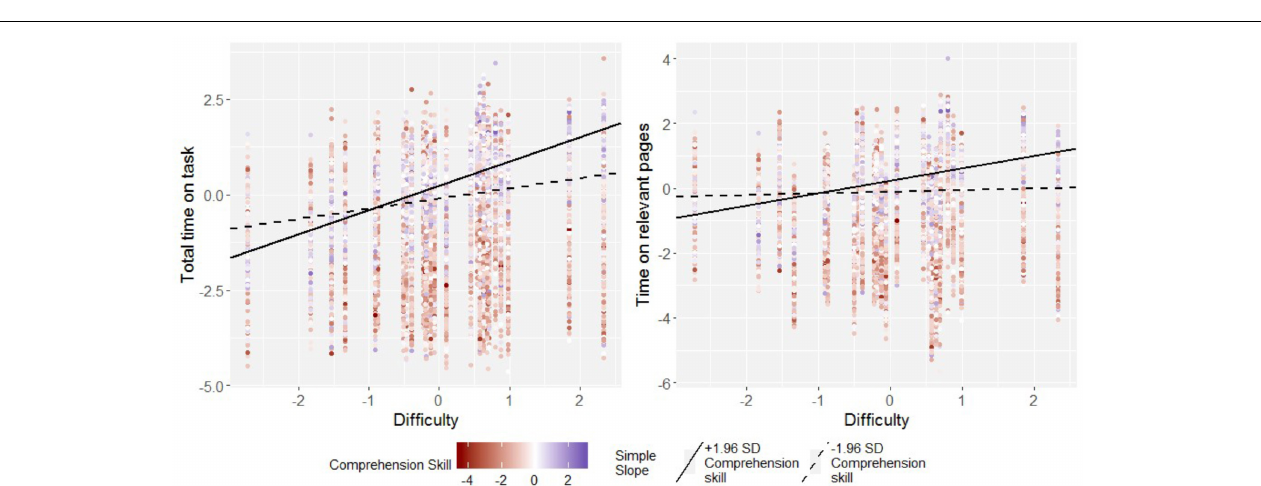
FIGURE 3 | Interaction of task difficulty with comprehension skill, knowledge of reading strategies, and reading motivation as predictor of total time on task (tot) and average time on relevant hypertext pages (rel). Error bars indicate 95% confidence intervals. Symbol sizes are proportional to precision of each estimate.